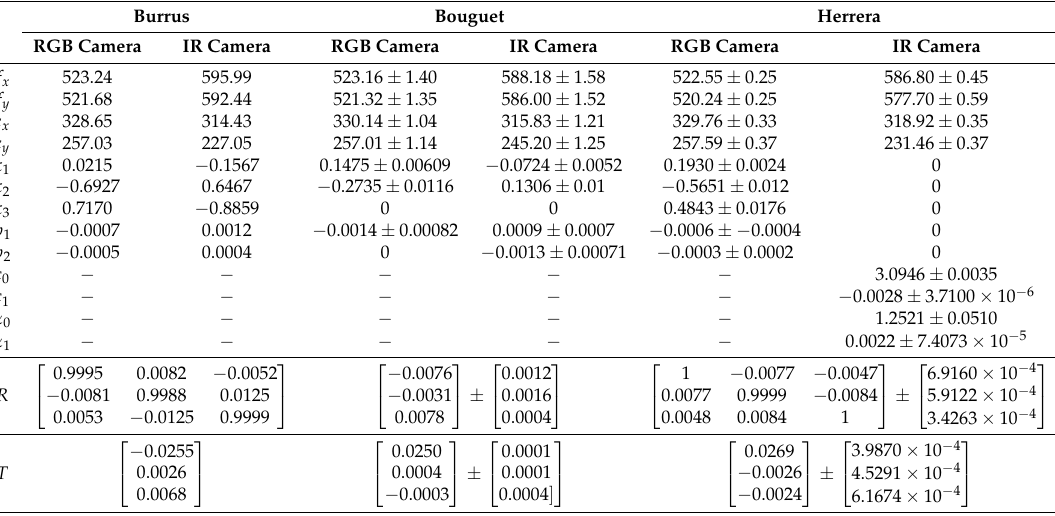
Table 3. Calibration results for Microsoft Kinect.